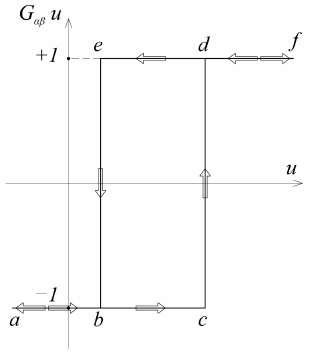
Figure 1. Elementary hysteresis operator.